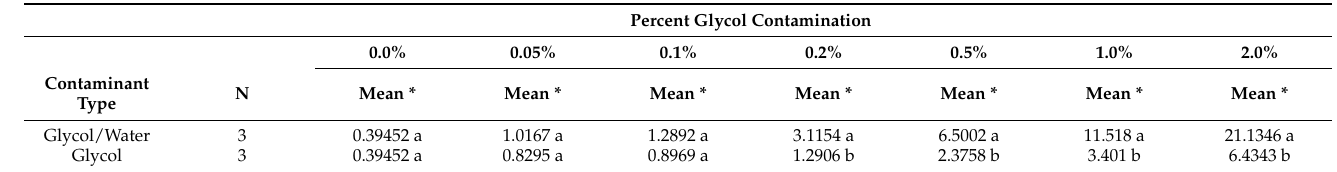
Table 3. Summary of the differences in contamination levels of the mean absorbance area in the 3150–3500 cm − 1 wavenumber range.